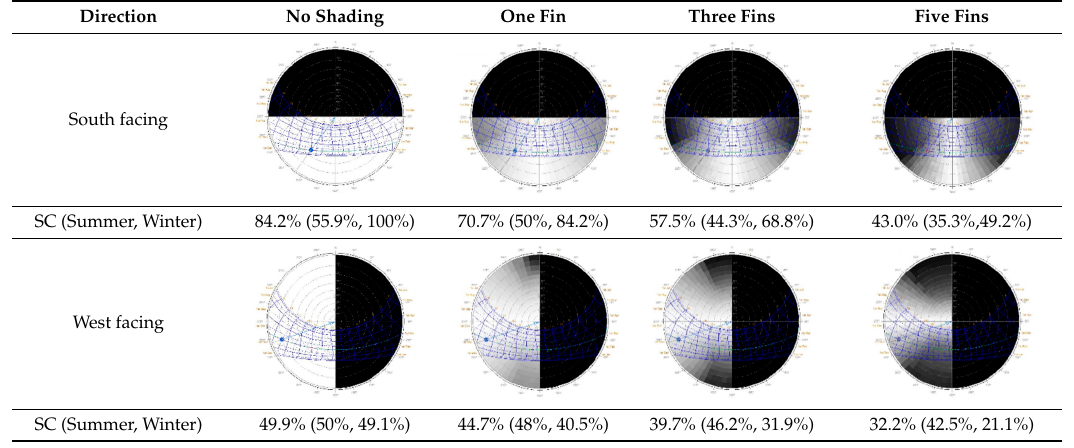
Table 3. Shading mask on the window south facing with vertical fins shadings.